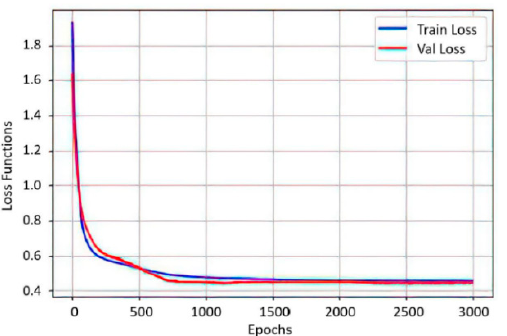
Figure 12. Graph of the accuracy trend of the neural network with new data (Train loss) and the trend of the loss function (Val loss). Neural network accuracy ratio after 3000 epochs.